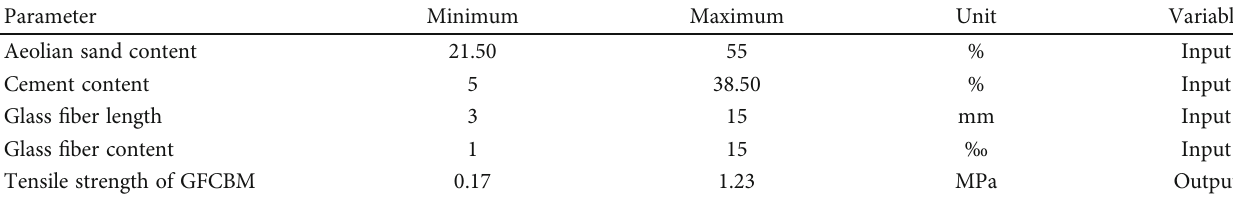
Table 2: Basic parameter statistics of the